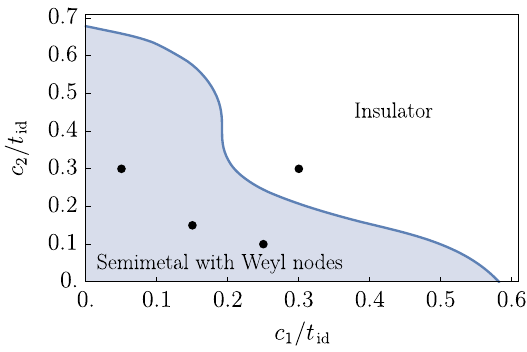
FIG. 4. Phase diagram for the Ir band structure in the parameter space of the f - d exchange couplings. The bold dots refer to the four parameter choices in Fig.